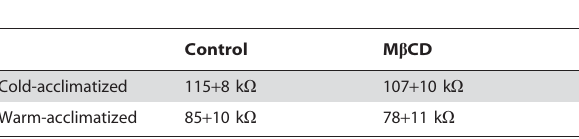
Table 1. Input resistances in deep abdominal extensor muscle fibers, estimated using current pulses of varying amplitude (i.e. ‘‘slope’’